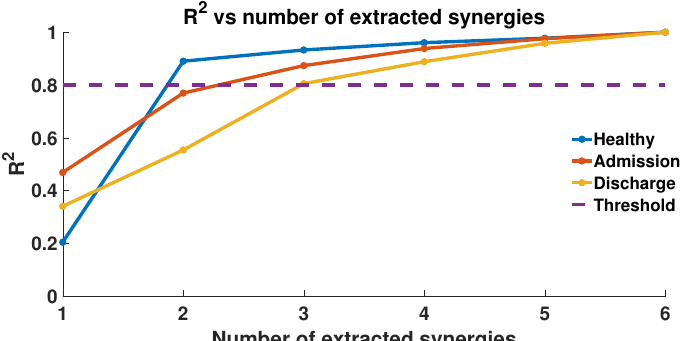
Figure 5. The coefficient of determination R 2 computed between mean EMG data and reconstructed EMG data for healthy limb and affected one at the admission and discharge. For N = 3, R 2 is above the threshold (0.8) in all the assessed conditions.